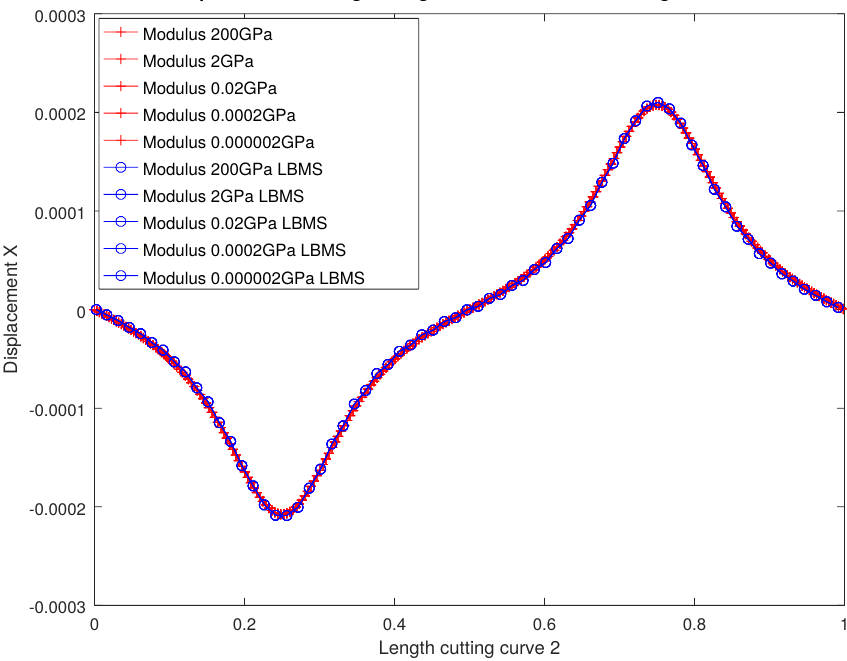
Figure A16. First displacement components along cutting curve C 2 for different Young’s